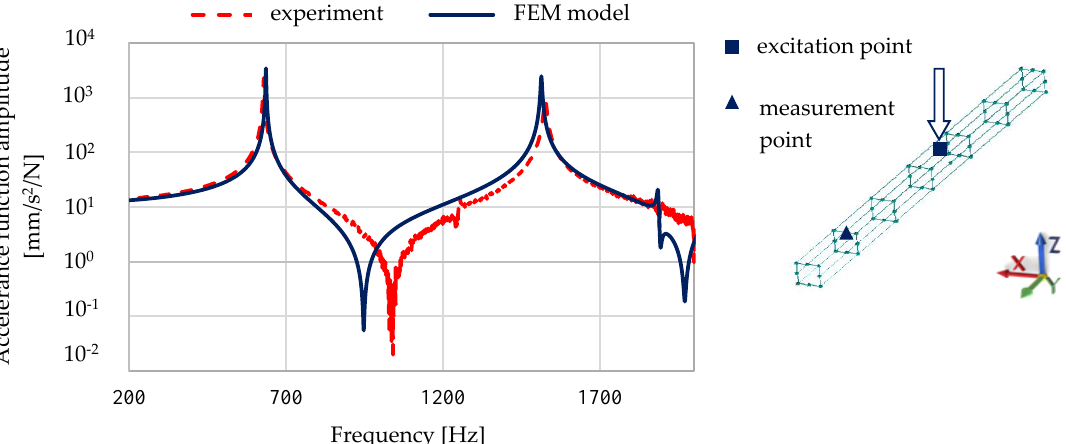
Figure 11. Comparison of calculated and experimentally determined accelerance functions for a 140 mm × 140 mm steel–polymer concrete beam.